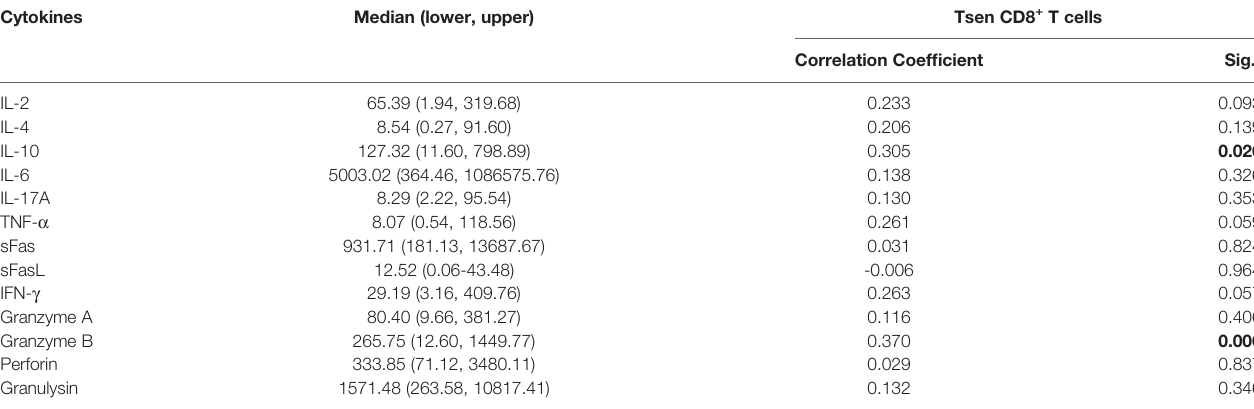
TABLE 6 | Ascites supernatants level of cytokines and their association with Tsen CD8 + T cells frequency in patients with HGSOC (n = 53). Cytokines Median (lower, upper)